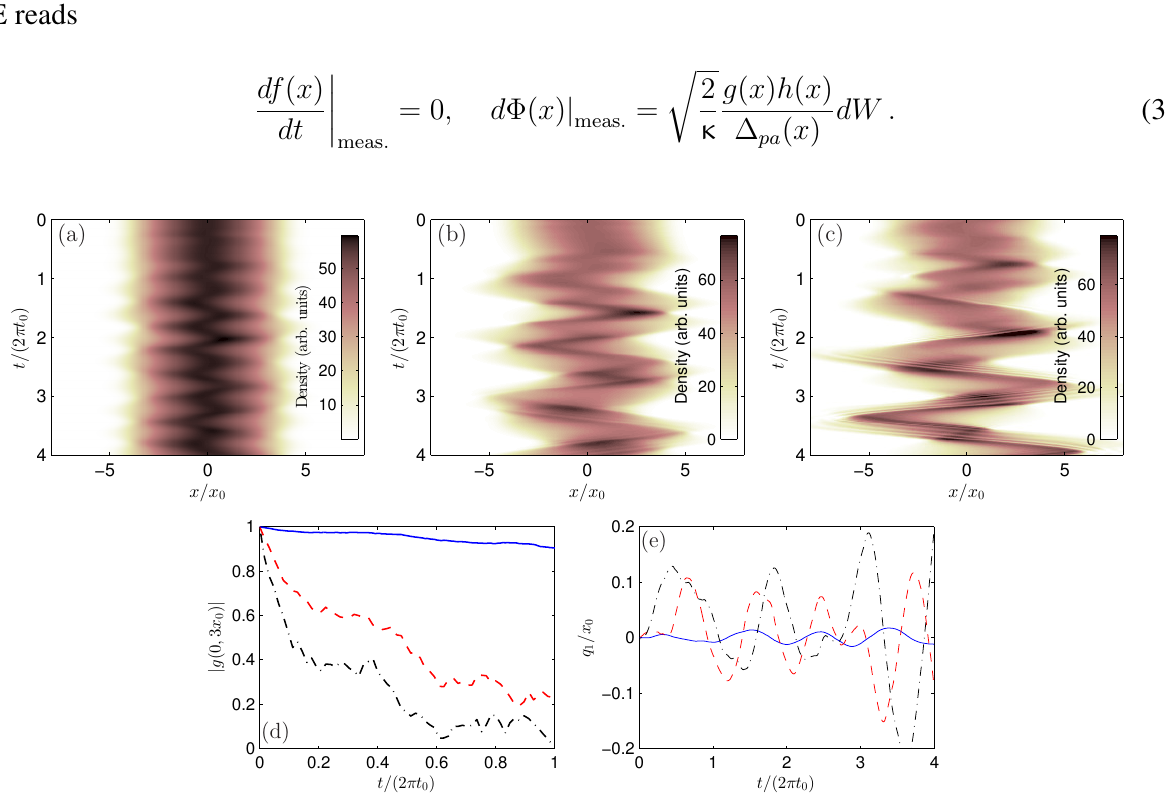
Figure 5. Effect of increasing transverse pump power h while driving the Kohn mode. (a) 0 Single realization of stochastic field density | ψ ( x, t ) | 2 evolution for pump power of h = ¯ h 0 0 g 2 / κ ∆ 2 ≈ 0 . 042 ω as was the case in Figure 2. ( b ) Single realization with h with ¯ h 2 . = 4¯ h 0 0 0 0 pa (c) Single realization with h . ( d ) Short-time dissipation induced loss of coherence = 6¯ h 0 0 (ensemble averaged over 200 realizations) showing the increase in dissipation with pump power, with h (blue, solid), h (red, dashed) and h (black, = ¯ h = 4¯ h = 6¯ h 0 0 0 0 0 0